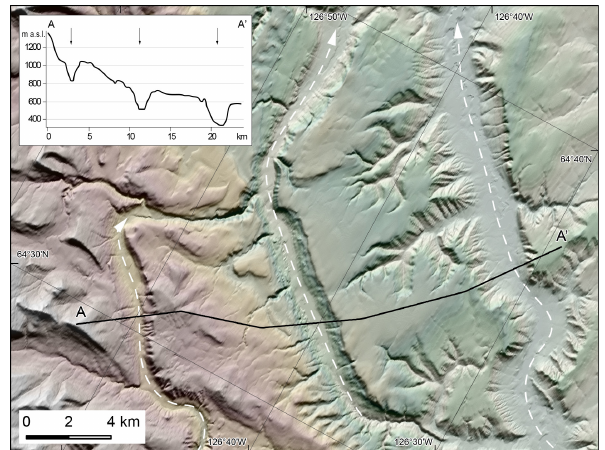
Figure 9. A series of large marginal spillways along the eastern slopes of the Mackenzie Mountains. White dashed arrows indicate the meltwater flow direction. The location of this figure is indicated in Fig.